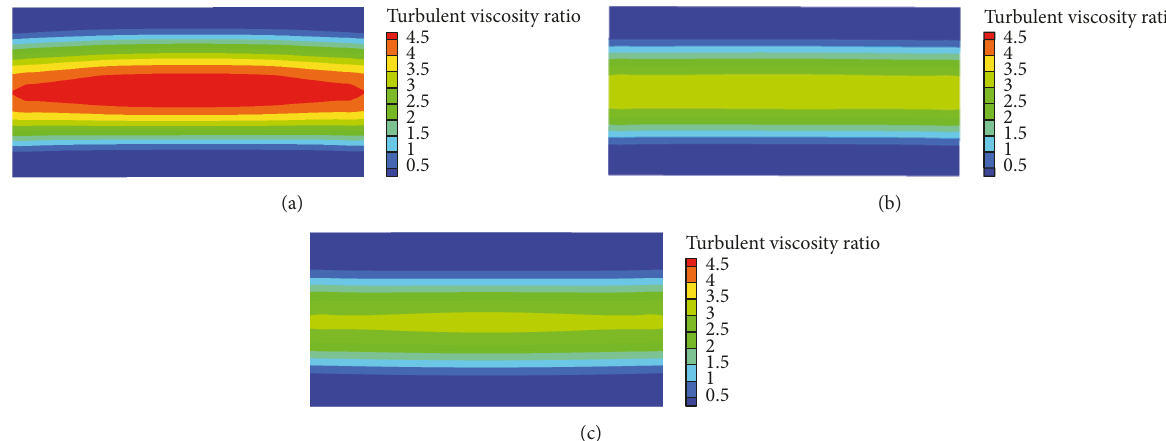
Figure 12: Contours of turbulent viscosity ratio in the sections simulated by SST model with low-Re correction. (a) 20 ∘ from the inlet; (b) 40 ∘ from the inlet; and (c) 60 ∘ from the